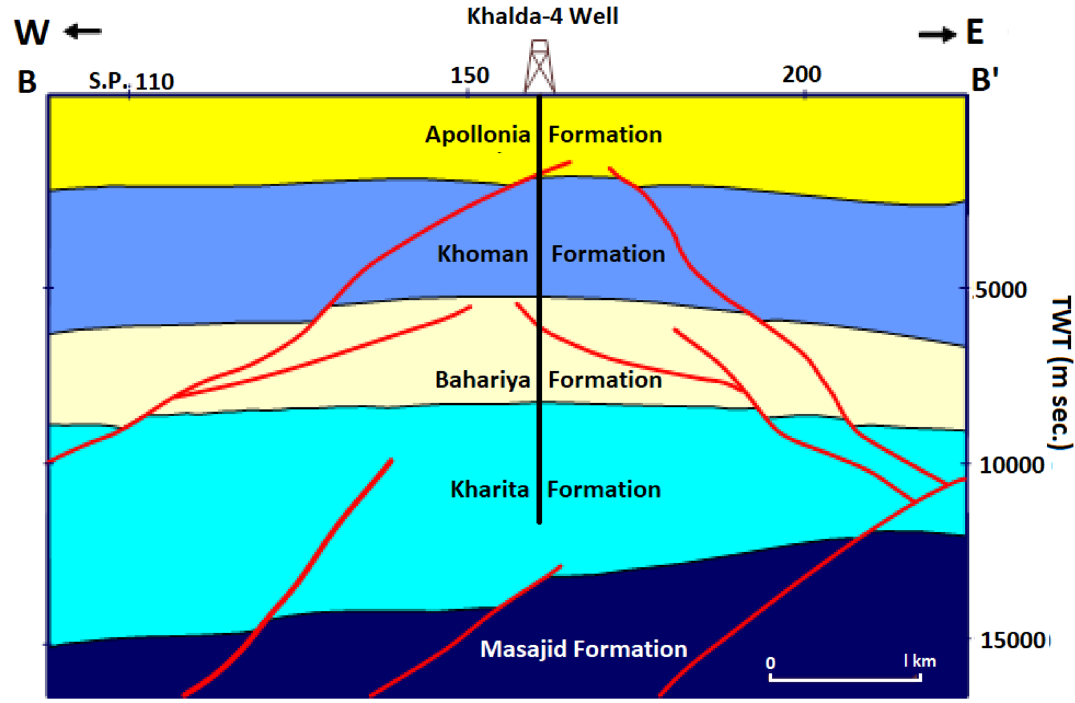
Fig. 6 E–W geoseismic cross section, crossing Khalda-4 well. Location is shown in Fig.